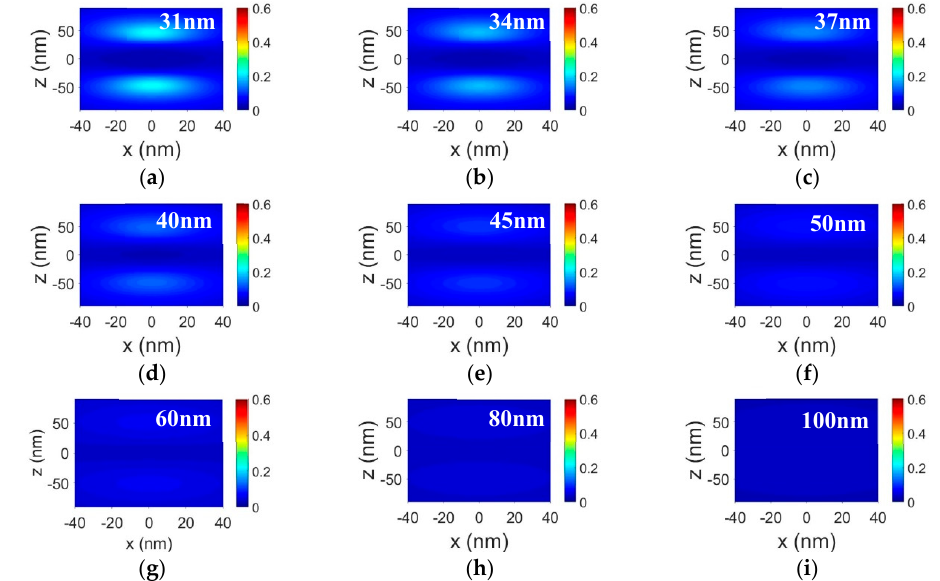
Figure 8. The electric field distributions of the silver nanorod with a diameter of 30 nm and a length of 100 nm for the TE polarization (along z direction). ( a – i ) The electric field profiles of E(x, z) at 340 nm in different near field regions when adding the 2D y-normal monitor in the positions of y = 31, 34, 37, 40, 45, 50, 60, 80, and 100 nm, respectively.